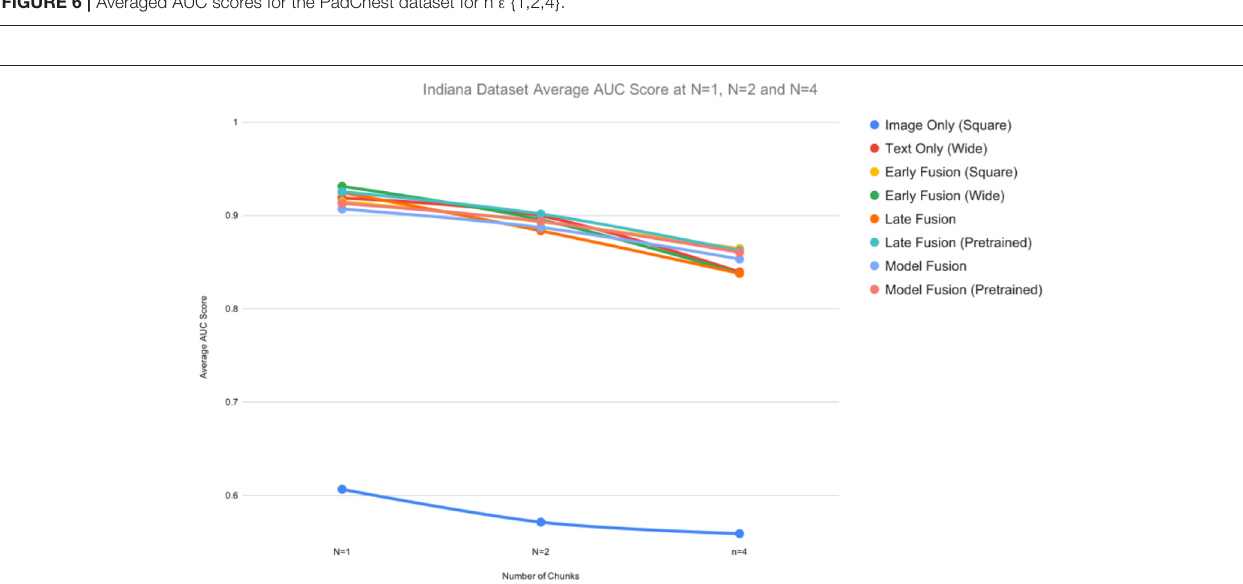
FIGURE 7 | Averaged AUC scores for the Indiana CXR dataset for n ε